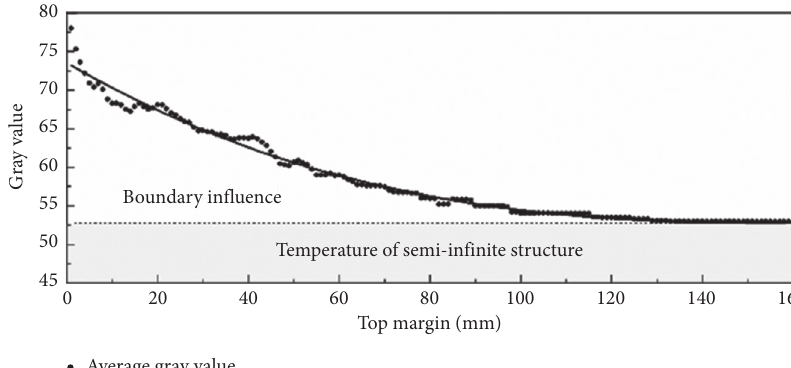
Figure 8: Edge temperature fitting.